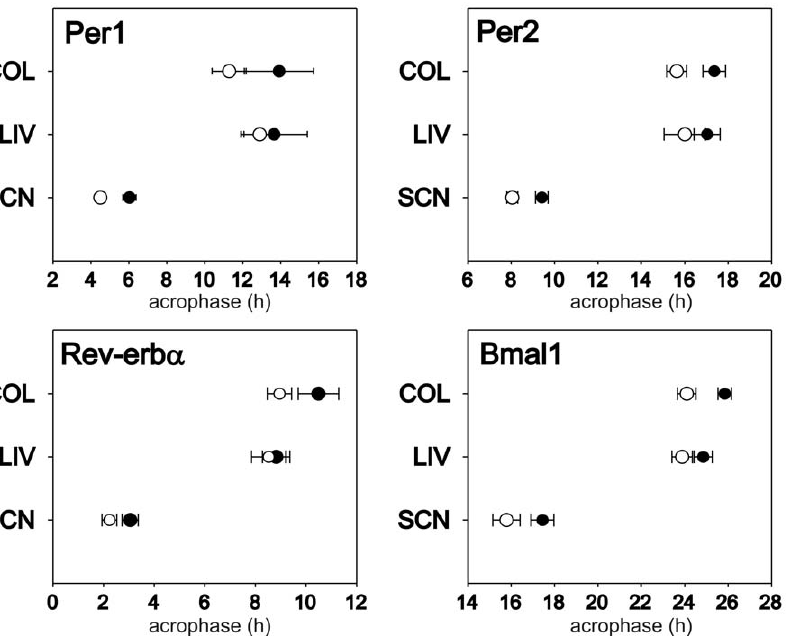
Figure 5. Comparison of acrophases of the circadian rhythms in clock gene expression in the SCN, liver (LIV) and colon (COL). The acrophases in the Wistar rats (full circle) and SHR (open circle) were determined on the basis of cosine fits of Per1 , Per2 , Rev-erb a and Bmal1 expression profiles shown in Fig. 2 and 3. Error bars represent S.D.